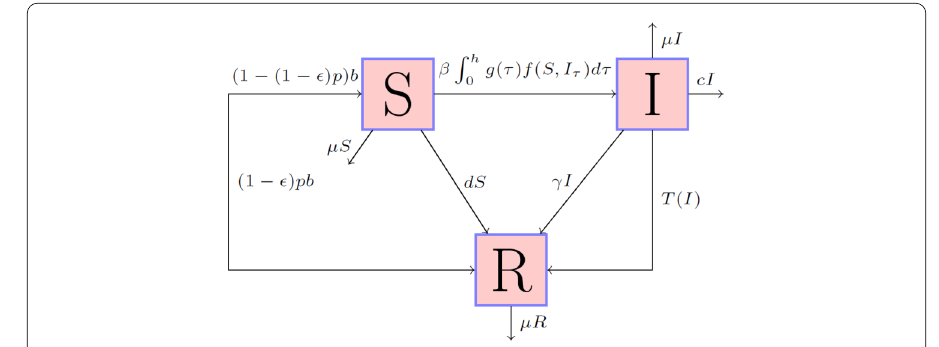
Figure 1 Flow diagram of the disease